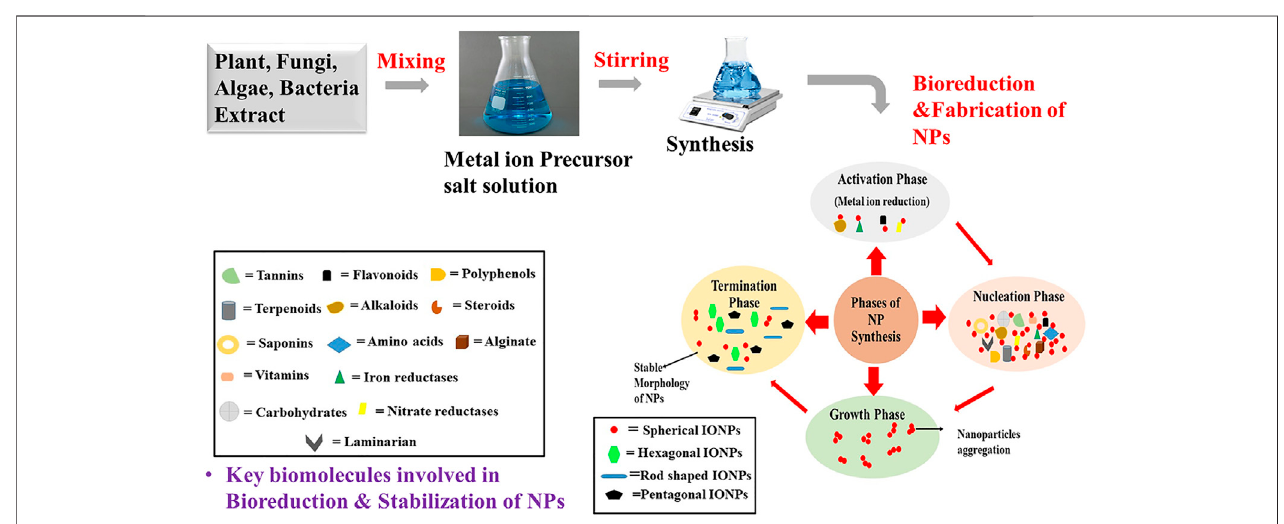
FIGURE 4 | Schematic representation of the mechanism of synthesis of metal oxide NPs by using plants, algae, fungi and bacteria.